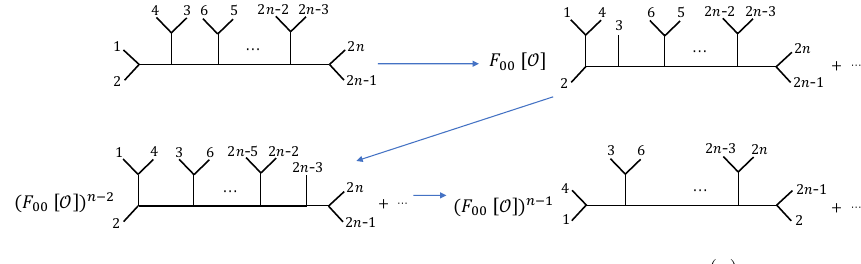
Figure 6. The fusion transformations to obtain ∆ S ( n )